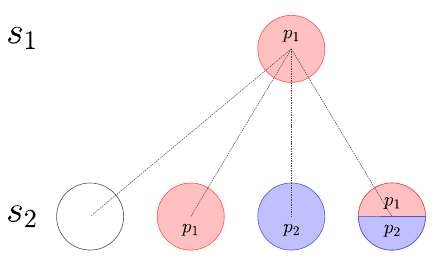
Figure 1. Branching for the pump operation ( n = 2 ) in the second time step after pump p 1 has been operated in the first time step. The colors red, blue and no color represent pumps p 1 and p 2 and no pump.